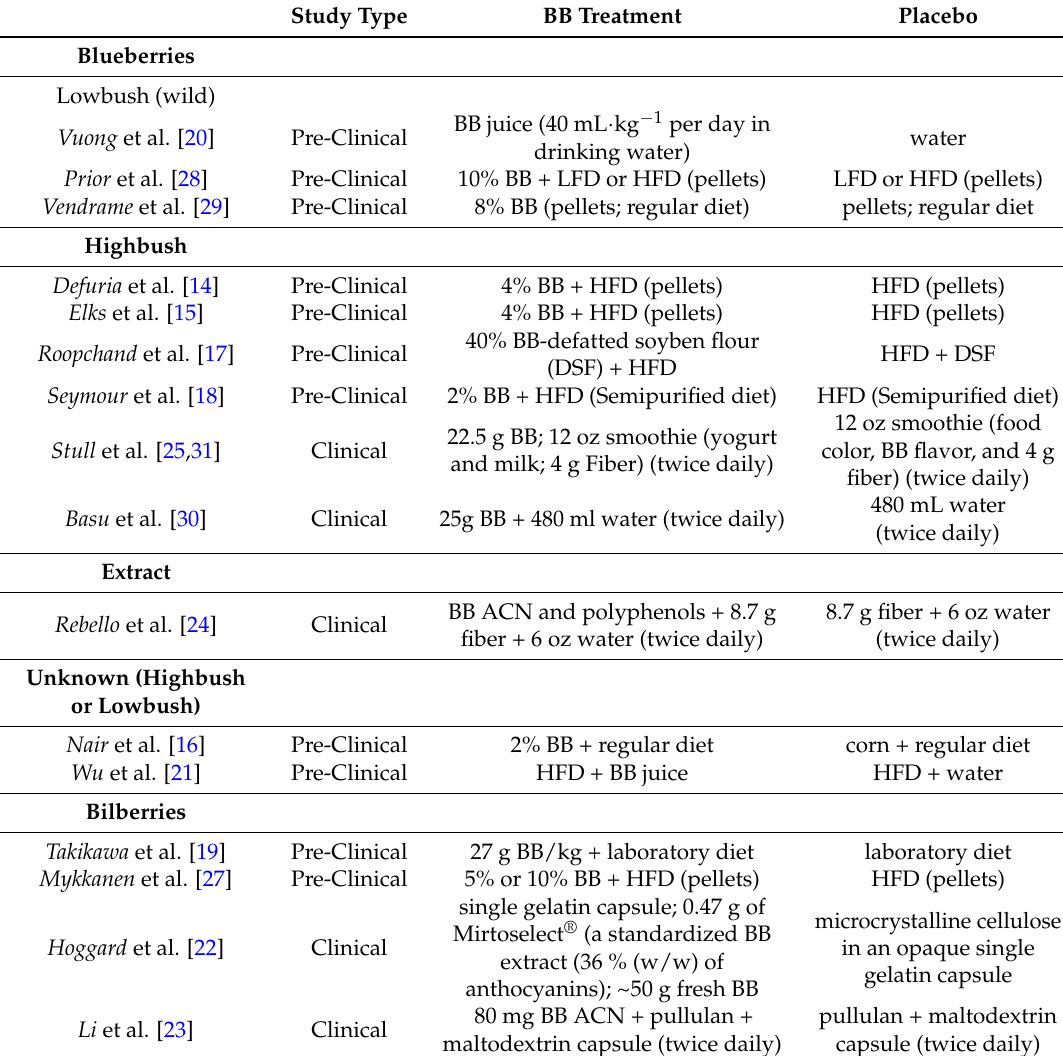
Table 1. Ingredients in the Blueberry Treatment and Placebo Drinks, Pellets, or